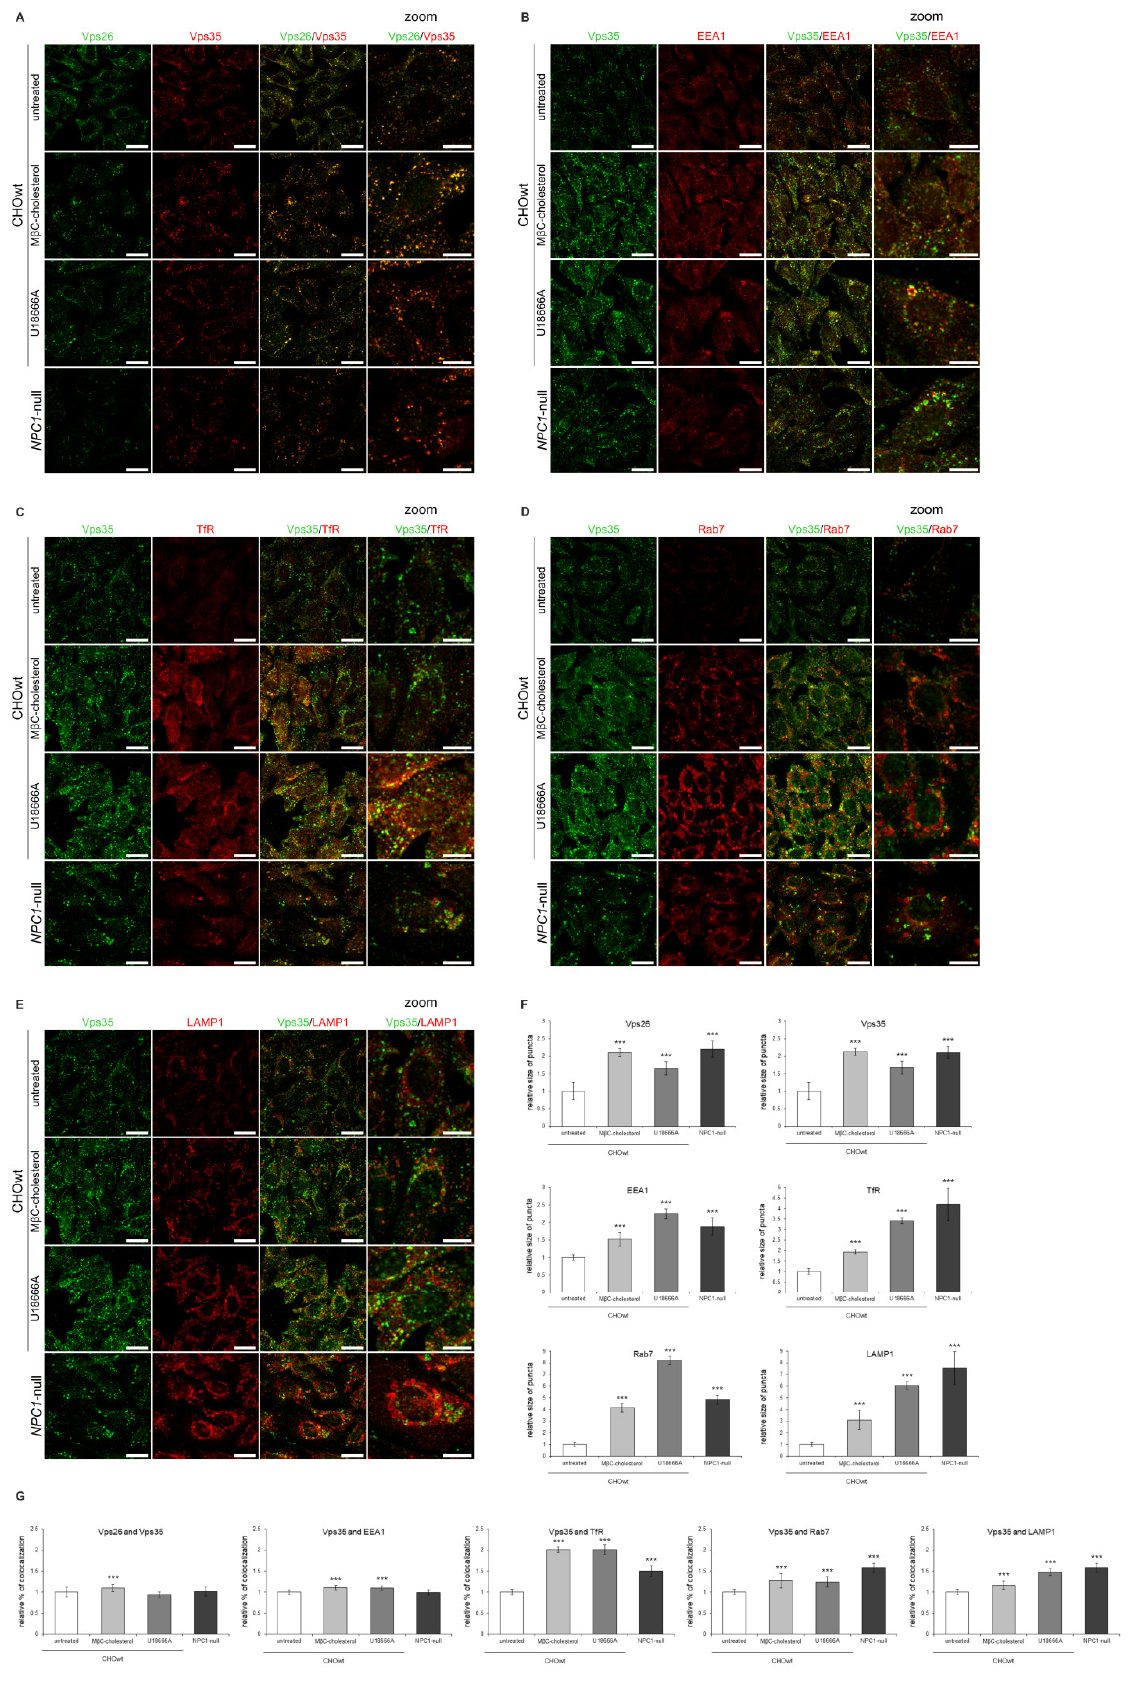
Figure 9. Cholesterol-loading in CHOwt cells causes retromer trafficking defect similar to that as in NPC1 -null cells. The cells were grown in 10% FBS in DMEM/F12 media. Cholesterol levels were increased in vitro in CHOwt cells using